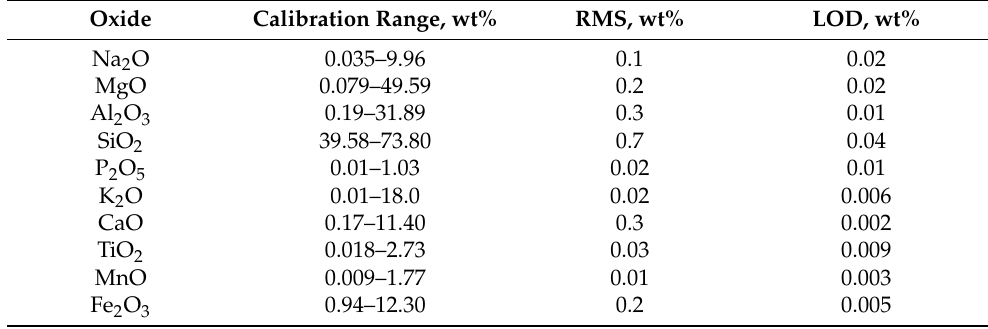
Figure 2. WDXRF spectra of the CRM of soil GSS-6 prepared as glass disk (red line) and the CRM of pine needles HSS-1 prepared as a pressed pellet (black line). Table 2. Statistical data obtained for WDXRF analysis of major oxides in soil